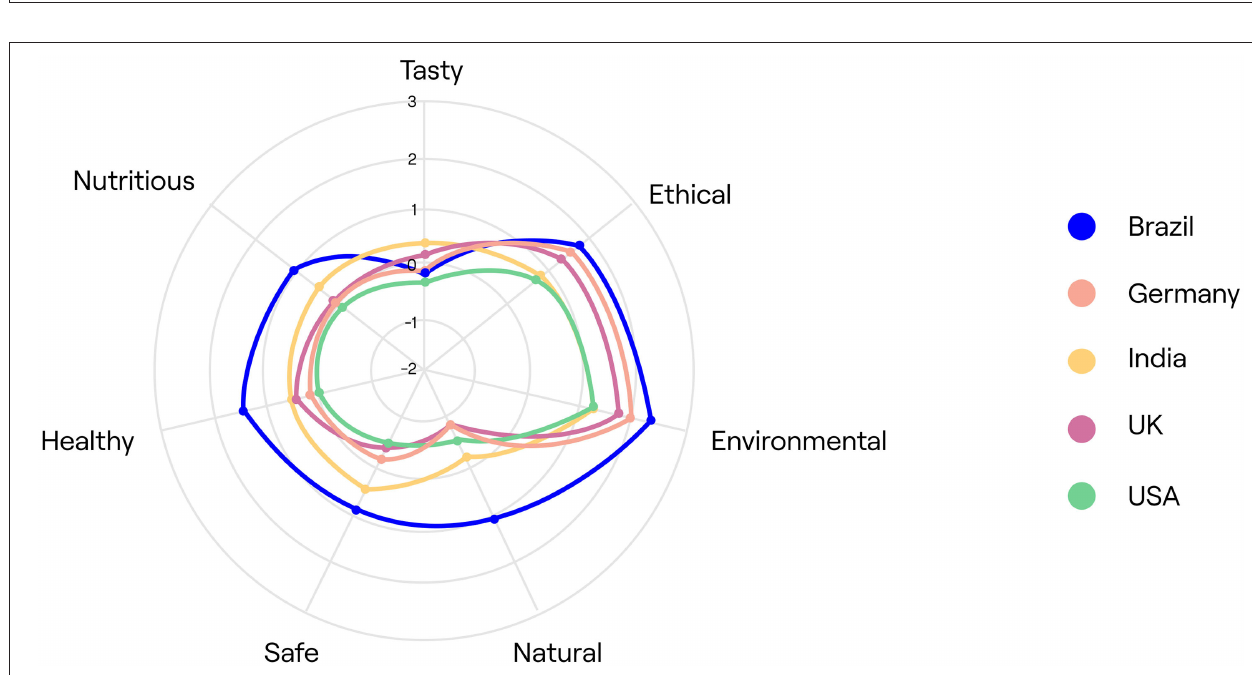
a basic animal-derived cheese. The product was noted as being distinctly less natural than basic cheese in all countries, apart from in Brazil where cheese produced using precision basic